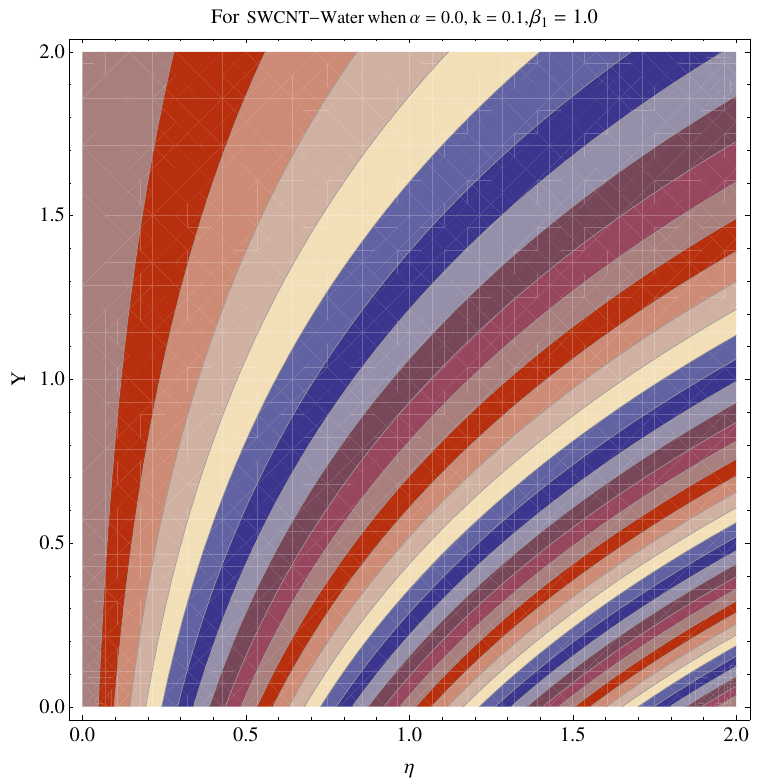
Figure 15. Contour graph at β 1 = 1.0 for SWCNT.